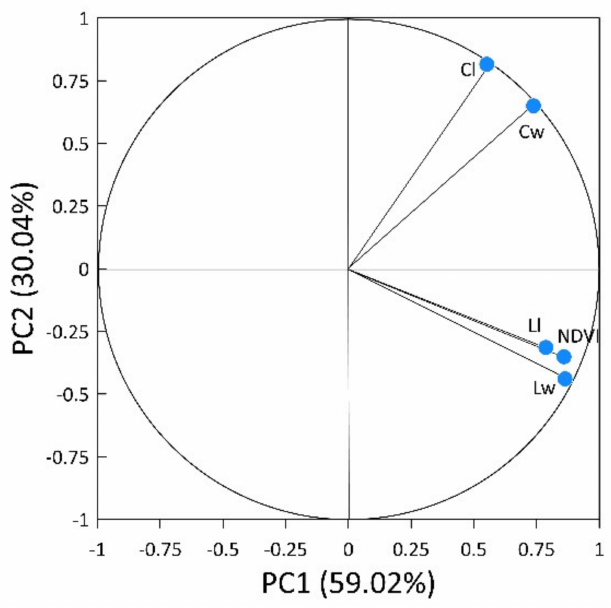
Figure 7. Principal component plot for the vegetative properties at the end of cauliflower growing.